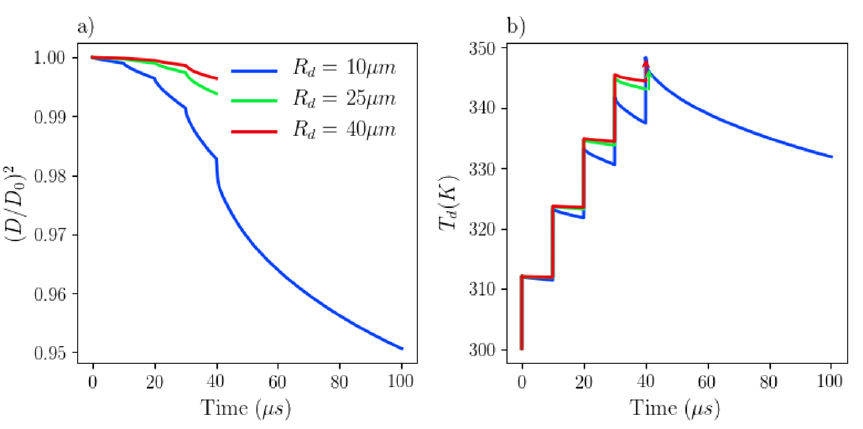
Figure 13. Temporal evolution of ( a ) normalized surface area and ( b ) droplet temperature for pulsed laser heating of ethanol droplets R 0 = 10 µ m, 25 µ m, 40 µ m with laser of λ = 1064 nm, 10 14 W/m 2 , 100 KHz repetition rate. I 0 = 0.5 ×